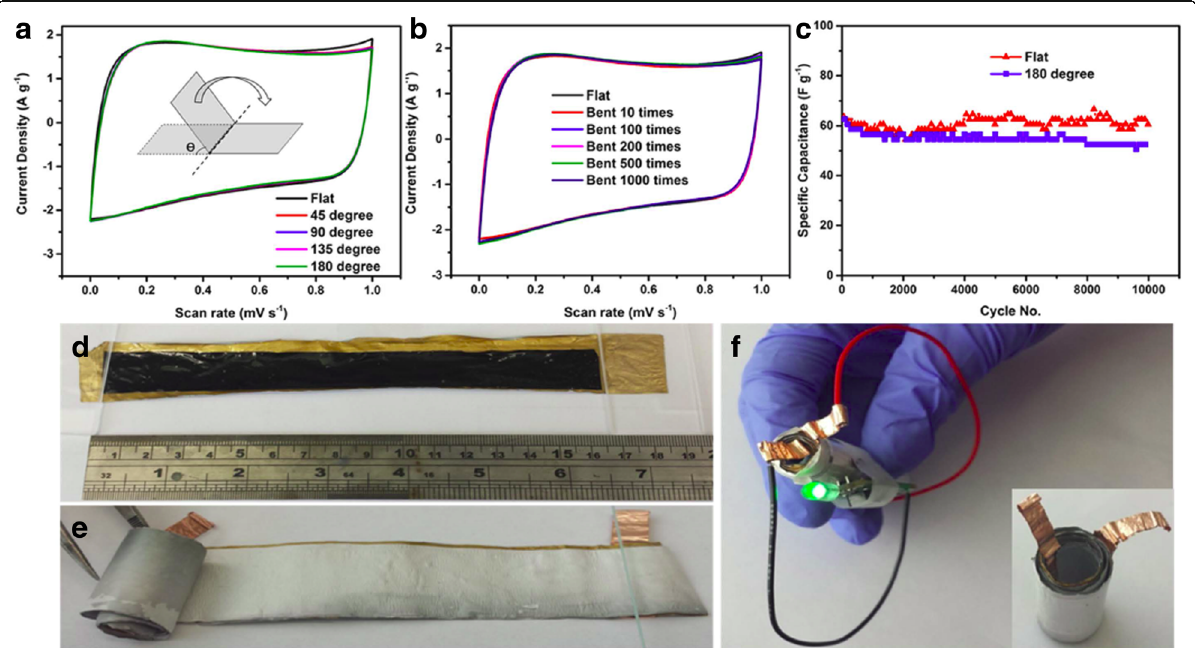
Fig. 13 a CVs of rGO-PEDOT/PSS during bending. Scan rate = 50 mV s − 1 . b CVs of rGO-PEDOT/PSS after being subject to bending. c Long-term test of rGO-PEDOT/PSS under flat or 180 ° bended states at a current density of 1 A g − 1 . d Flexible films coated with solid electrolyte spread out on an Au-coated membrane, e rolled design, and f the resulting device used to power a green light-emitting diode (LED). Reprinted with permission